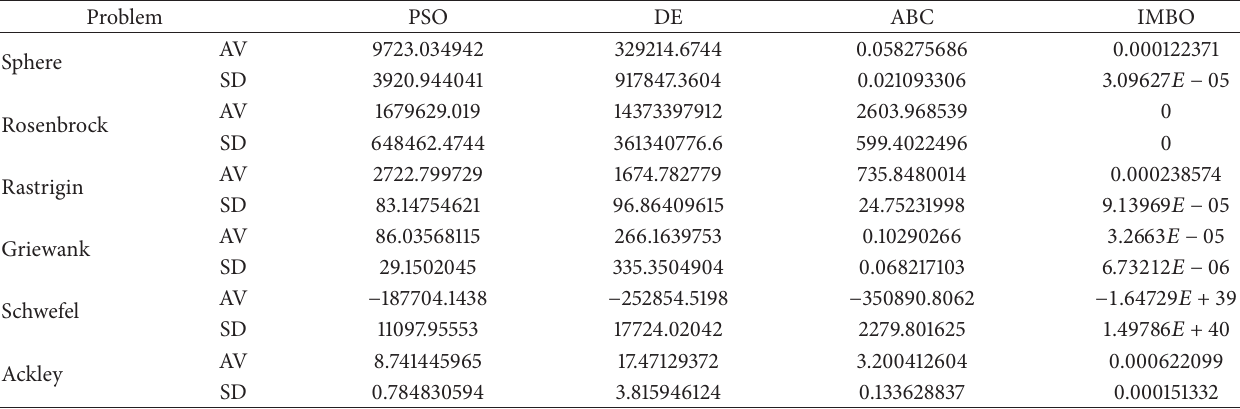
Table 13: The mean solutions obtained by the DE, PSO, ABC, and IMBO algorithms for 6 test functions over 30 independent runs and total success numbers of algorithms. Genotype size: 1000; (—): not available value, SD: standard deviation, AV: global minimum average.